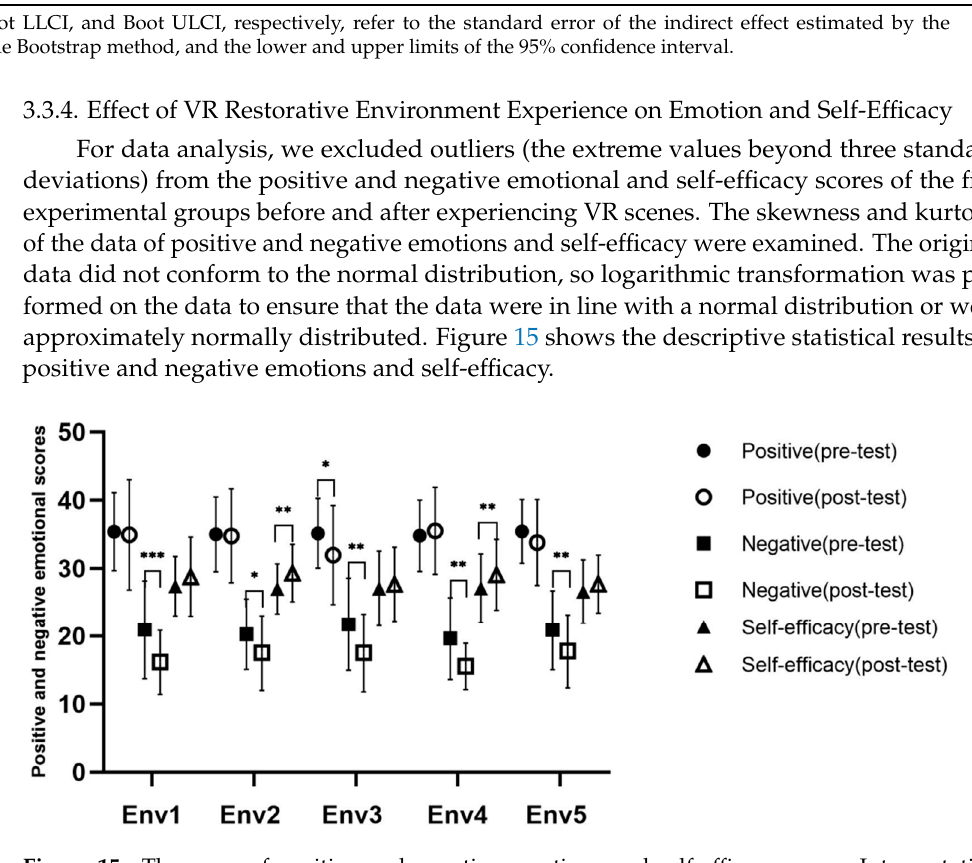
Figure 15. The score of positive and negative emotions and self-efficacy score. Interpretation: * p < 0.05, ** p < 0.01, and *** p < 0.001. Env1, VR urban environment visual experiencing group; Env2, VR